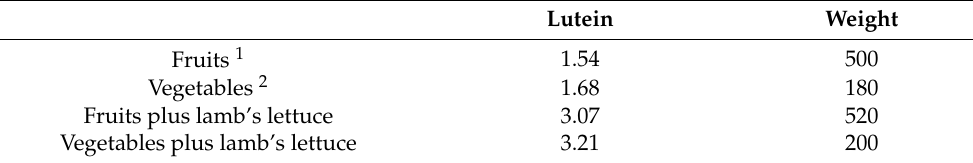
Table 2. Lutein ( µ mol/day) was supplied by fruit and vegetable addition (g/day) to the